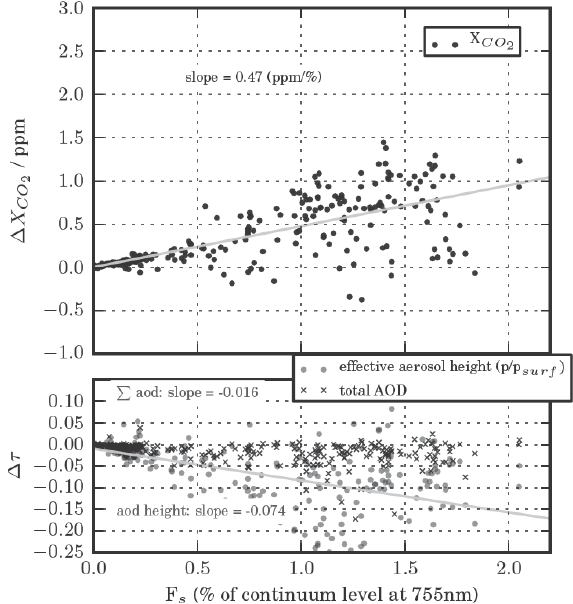
Fig. 5. Case #3a: Changes in retrieved X CO duced by chlorophyll fluorescence if it is ignored in the retrieval step. Identical to case #2a, Fig. 4, with the only difference that sur- face pressure is assumed known in the retrieval, i.e., not fitted.